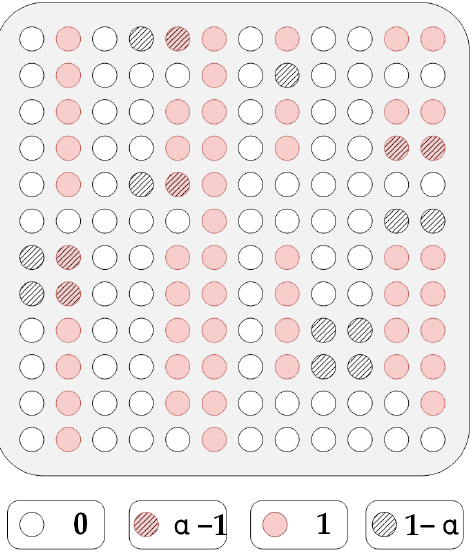
Figure 12. The attn_mask matrix, where 1 (solid circle) and 0 (hollow circle) represent masked and non-masked cases.